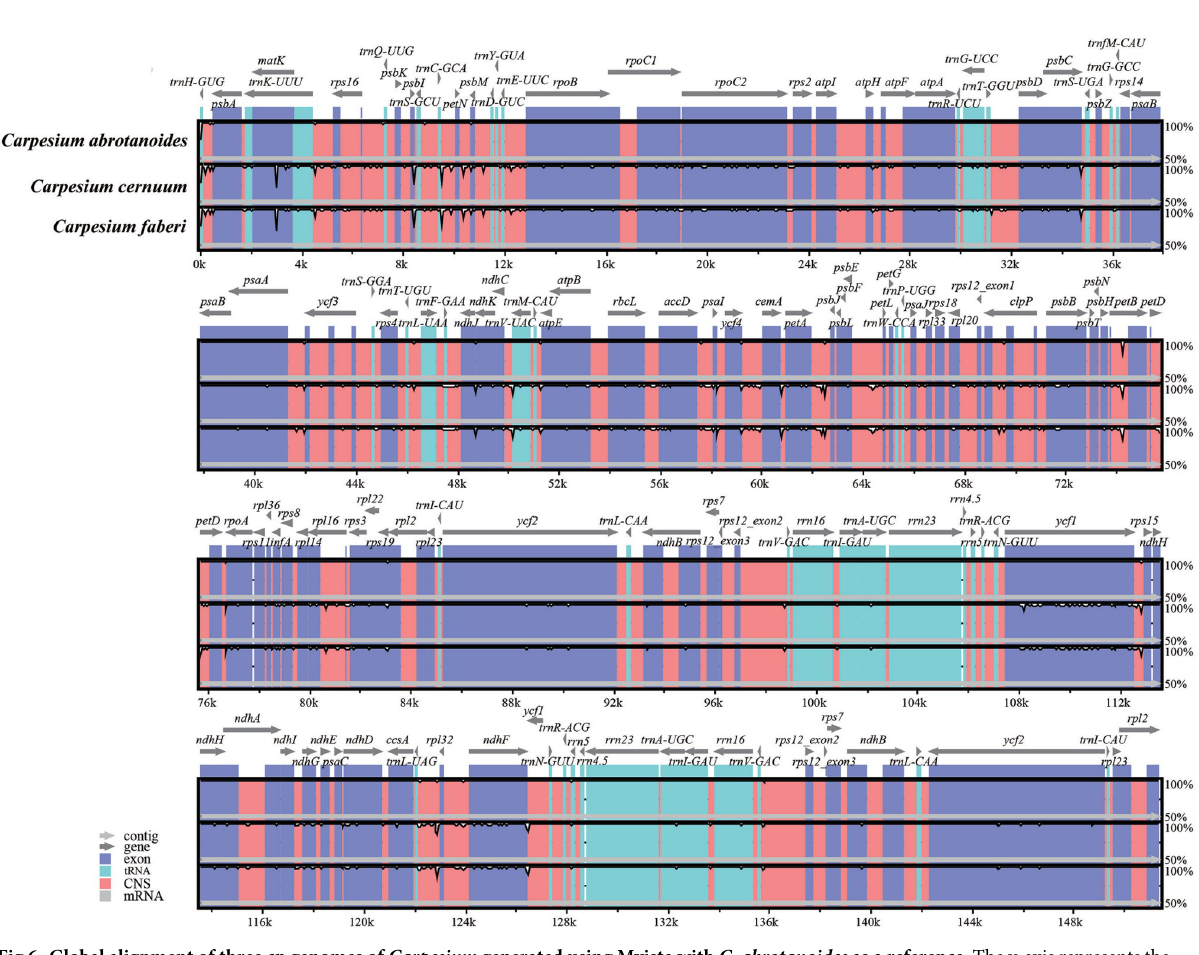
Fig 6. Global alignment of three cp genomes of Carpesium generated using Mvista with C . abrotanoides as a reference. The y-axis represents the range of identity (50%–100%). The x-axis indicates the coordinate in the cp genome. The gray arrows above the comparison represent the gene orientation and location, and different colors indicate the various regions of the